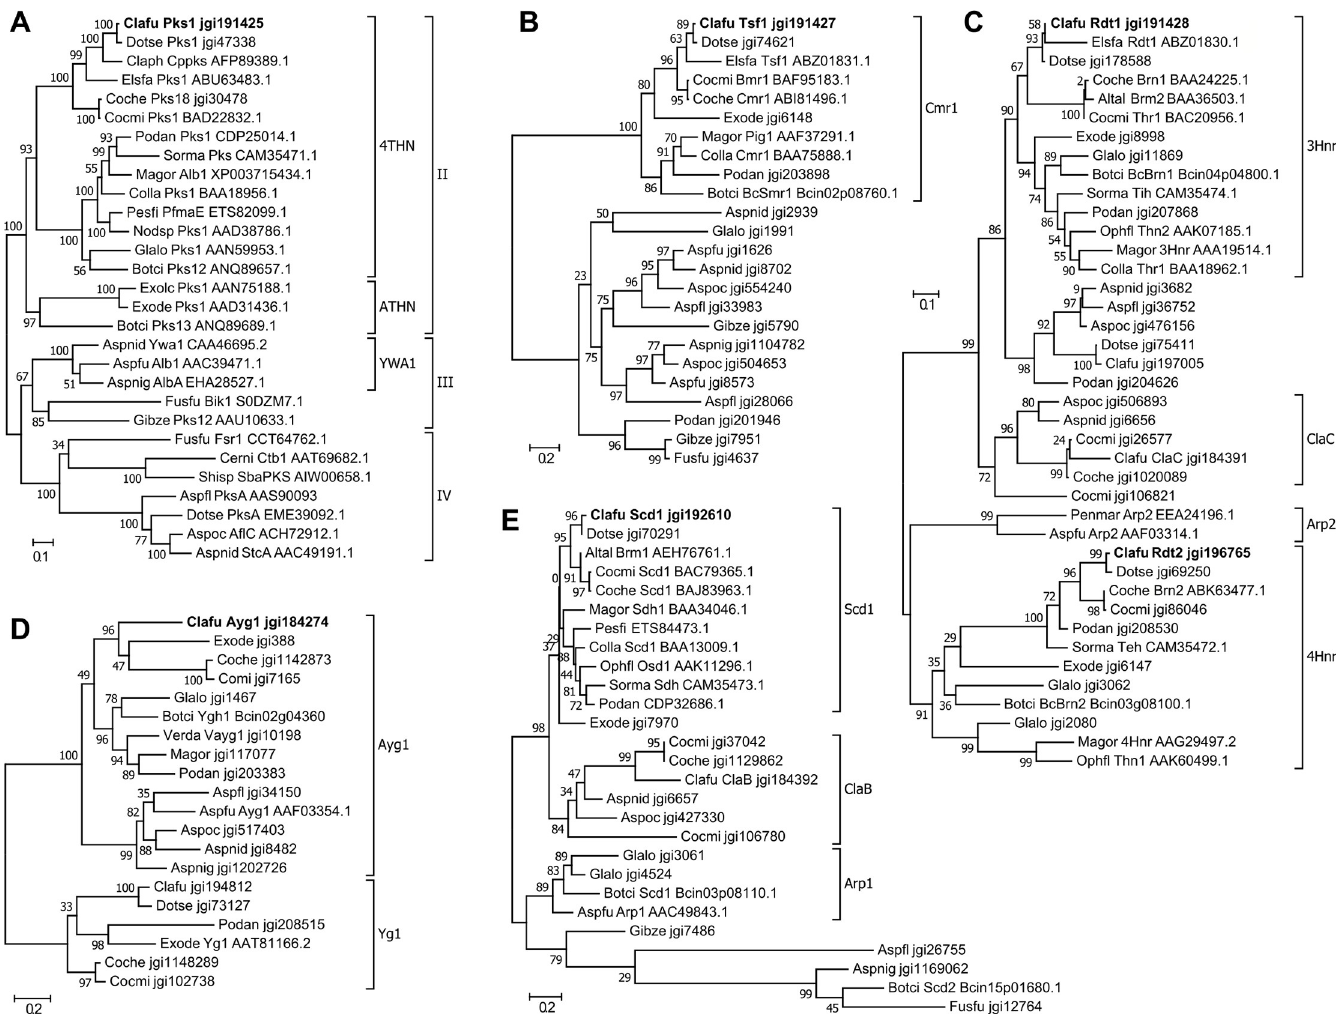
Fig 2. Phylogenetic analysis of proteins involved in DHN melanin biosynthesis. Maximum likelihood phylogenetic trees were built to resolve the evolutionary relationship of (A) CfPks1 to characterized non-reducing polyketide synthases; (B) CfTsf1 to characterized regulators of DHN melanin biosynthesis; (C) CfRdt1 and CfRdt2 to reductases involved in the reduction of 1,3,8-trihydroxy- and 1,3,6,8-tetrahydroxy-naphthalene, respectively; (D) CfAyg1 to characterized hydrolases involved in polyketide deacetylation; and (E) CfScd1 to characterized scytalone dehydratases. Elsinoe fawcettii proteins assigned to the elsinochrome gene cluster are included [41]. Non-characterized homologues are also included for species in which the polyketide synthase involved in DHN synthesis is characterized. The name of characterized proteins and accession numbers (GenBank, SwissProt or Joint Genome Institute (JGI) protein ids) are indicated next to the species acronym. Clafu: Cladosporium fulvum ; Dotse: Dothistroma septosporum ; Claph: Cladosporium phlei ; Elsfa: Elsinoe fawcettii ; Coche: Cochliobolus heterostrophus ; Cocmi: Cochliobolus miyabeanus ; Podan: Podospora anserina ; Sorma: Sordaria macrospora ; Magor: Magnaporthe oryzae ; Colla: Colletotrichum lagenarium ; Pesfi: Pestalotiopsis fici ; Nodsp: Nodulisporium sp .; Glalo: Glareae lozoyensis ; Botci: Botrytis cinerea ; Exolc: Exophiala lecano-cani ; Exode: Exophiala dermatitidis ; Aspnid: Aspergillus nidulans ; Aspfu: Aspergillus fumigatus ; Aspnig: Aspergillus niger ; Fusfu: Fusarium fujikoroi ; Gibze: Gibberella zeae ; Cerni: Cercospora nicotianae ; Shisp: Shiraia sp .; Aspfl: Aspergillus flavus ; Aspoc: Aspergillus ochraroseus ; Altal: Alternaria alternata ; Ophfl: Ophiostoma floccosum ; Penmar: Penicillium marneffei ; Verda: Verticillium dahliae .